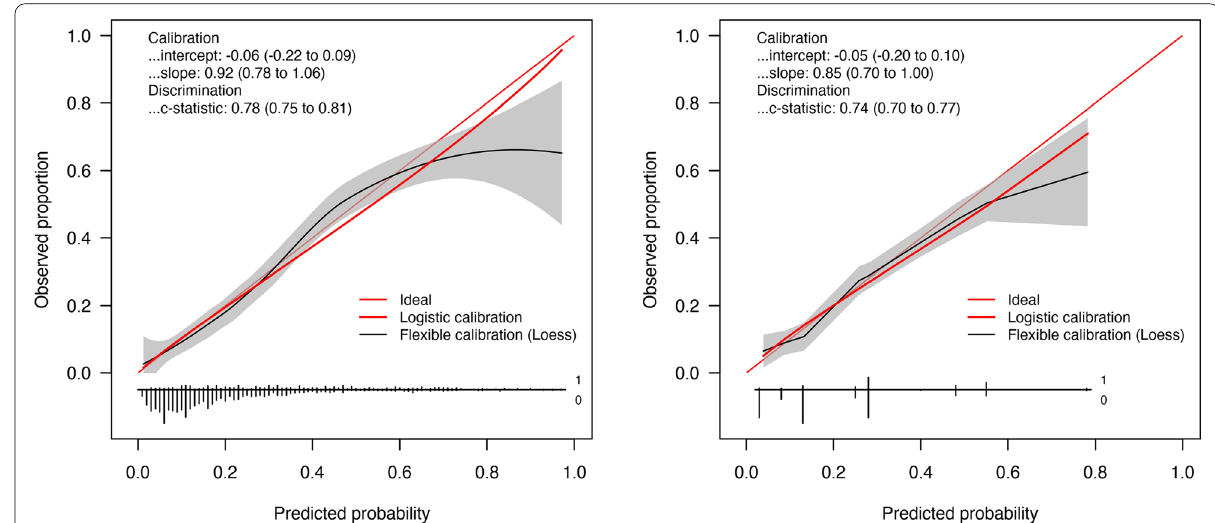
Fig. 2 Calibration plots for the logistic regression models M ABE